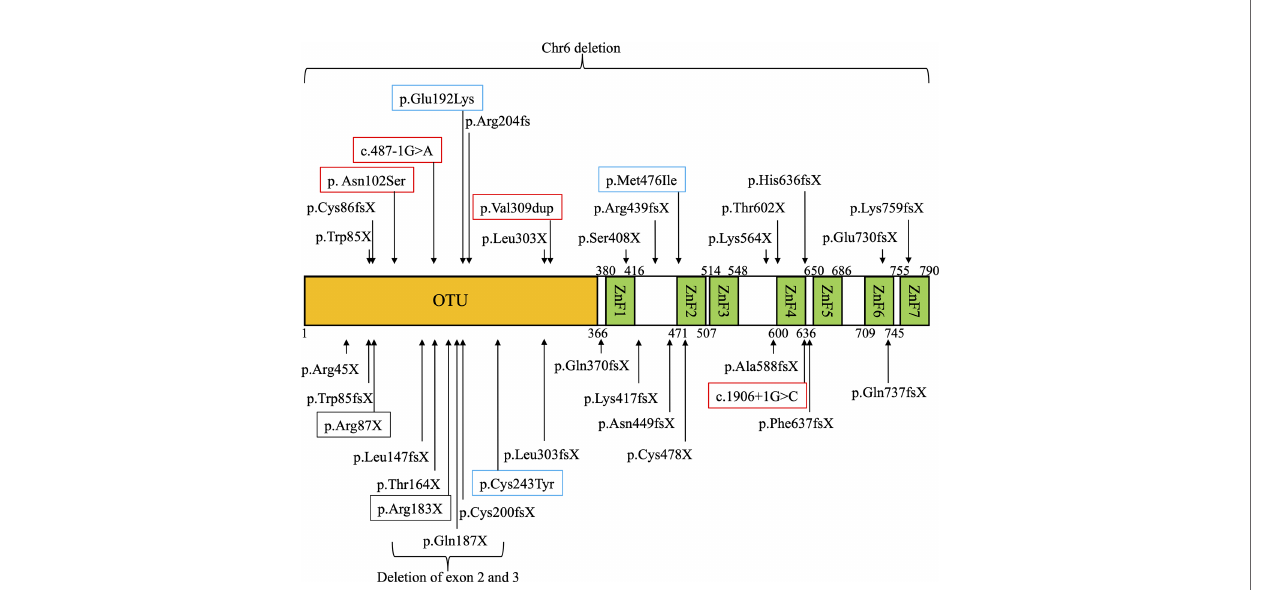
FIGURE 1 | Domain structure of A20 and locations of TNFAIP3 gene mutations in East Asian patients with A20 haploinsuf fi ciency (HA20). Mutations of TNFAIP3 reported in East Asia are indicated with arrows on the domain structure of A20. Three mutations whose pathogenic functions were evaluated by in vitro functional analysis are shown in blue squares. Four mutations whose pathogenic functions were not evaluated by in vitro functional analysis are shown in red squares. The mutations overlapping between different families are shown in black